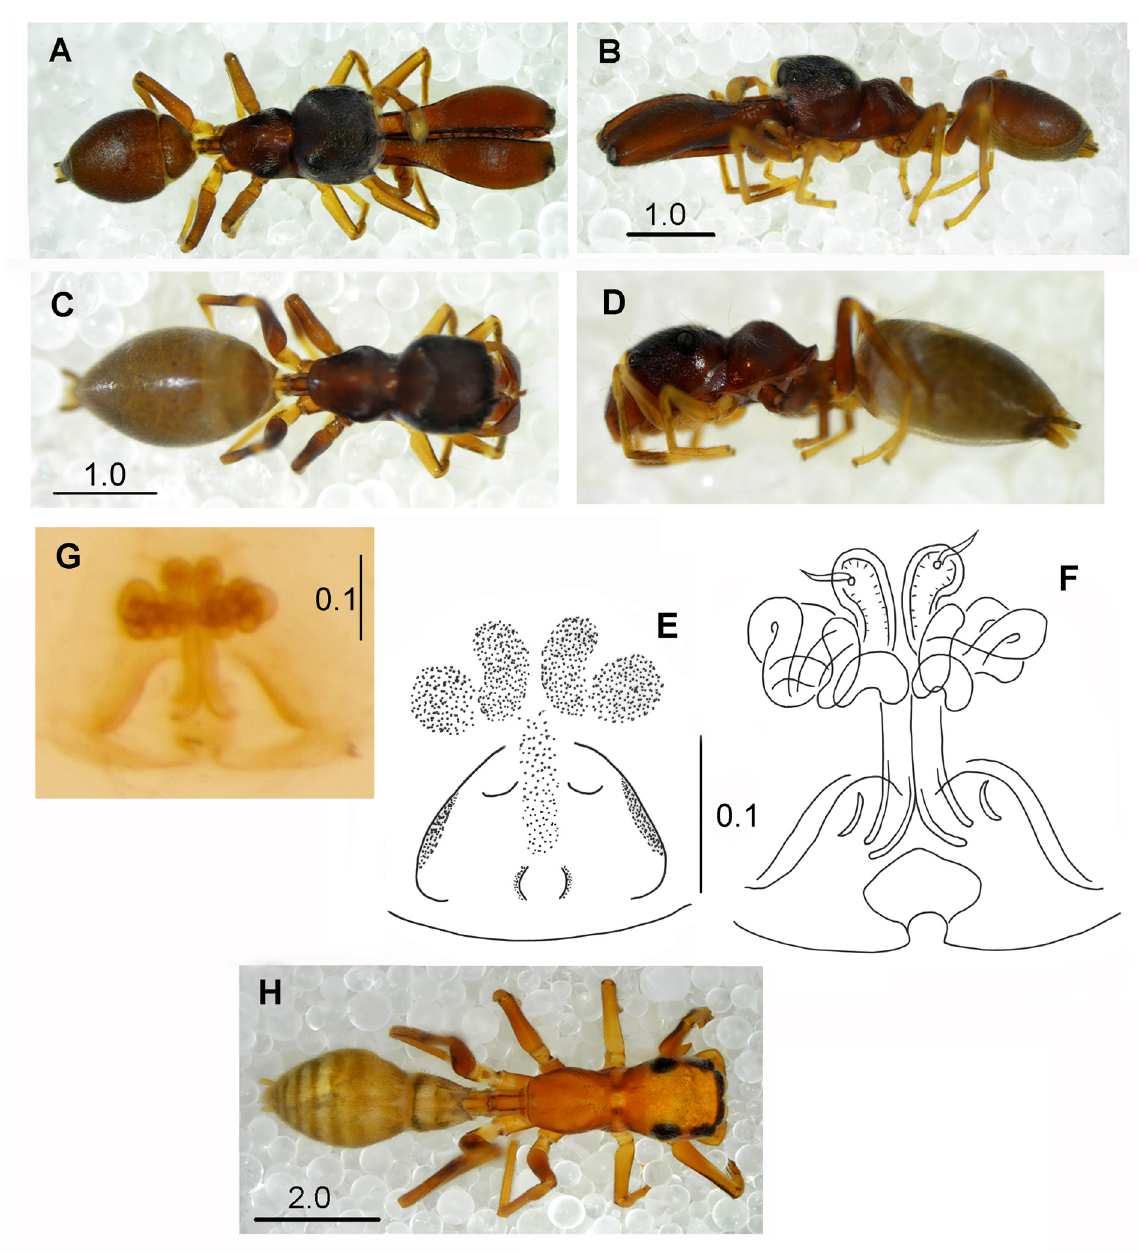
Fig. 38. A–G . Myrmarachne eidmanni Roewer, 1942, ♂♀ (MNHN). H . Myrmarachne foenisex Simon, 1909, ♀ (MNHN). A, C, H . Habitus, dorsal view. B, D . Habitus, lateral view. E . Epigyne. F–G . Internal structure of